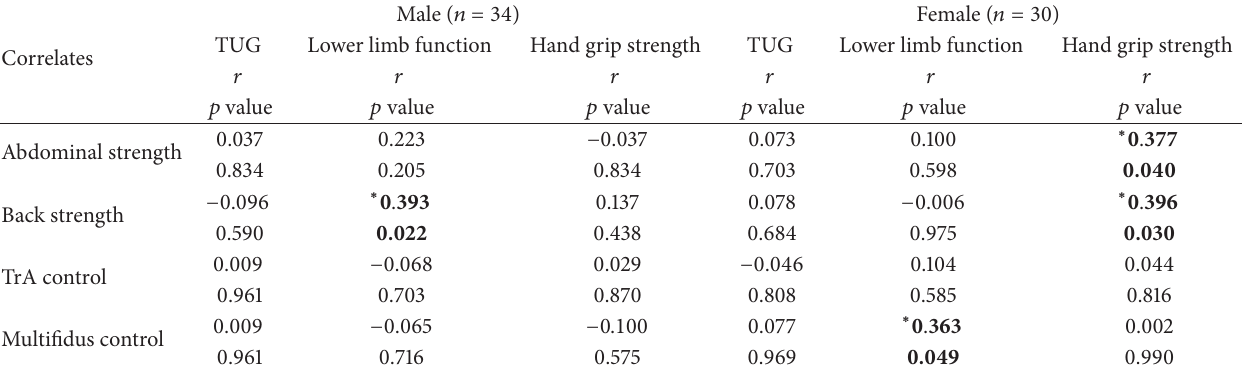
Table 2: Pearson’s correlation coefficient of functional performances and muscle functions among genders in LBP group ( 𝑛 = 64 ).